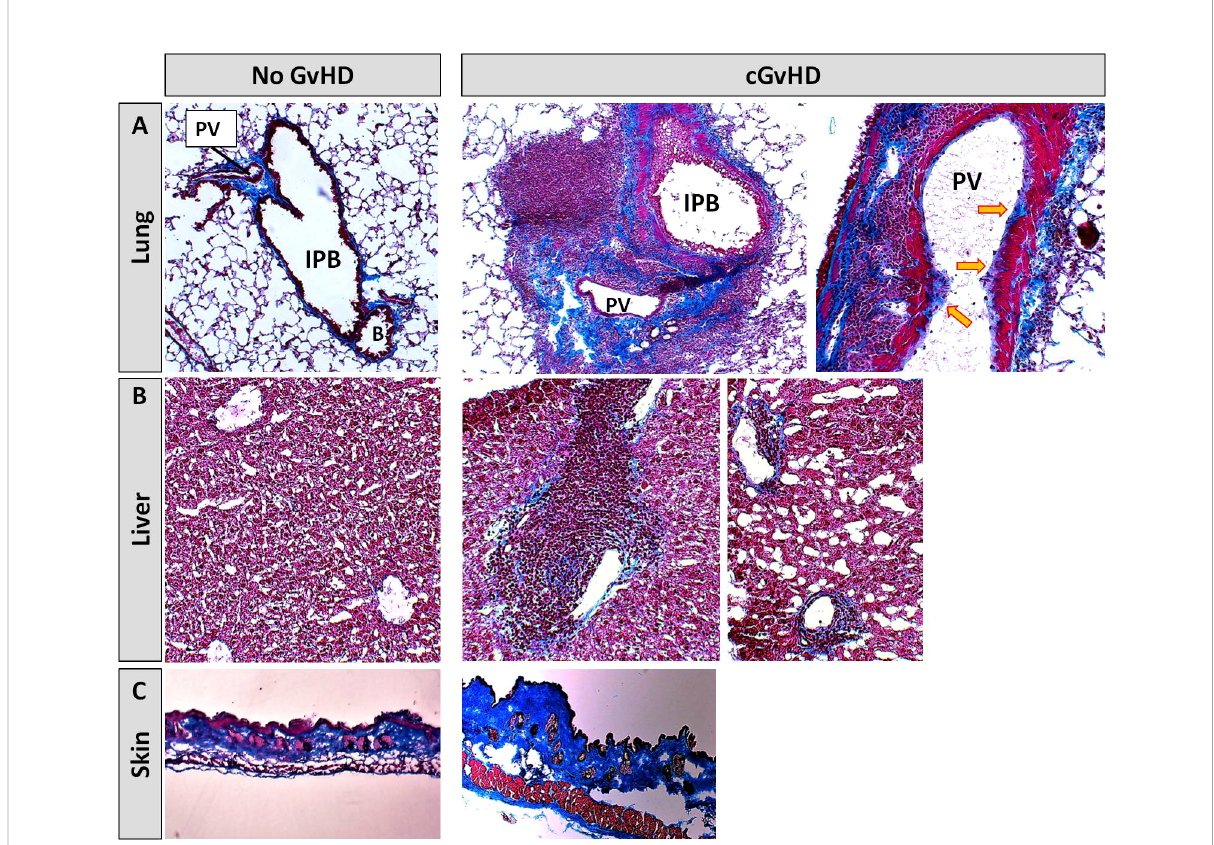
FIGURE 5 Histological characterization of murine cGvHD at day+125 after allo-HCT. Masson ’ s trichrome fi brosis staining in cGvHD target organs (A) lung, (B) liver and (C) skin of syn- and allo-transplanted BDF1-recipients. Blue, collagen fi bres ( fi brosis); red, cytoplasm; keratin, muscle fi bers and erythrocytes, dark red/black, nuclei; in fi ltrating immune cells. 20x magni fi cation. PV, Pulmonary vein; IPB, Intrapulmonary bronchus; B, Bronchiolus.